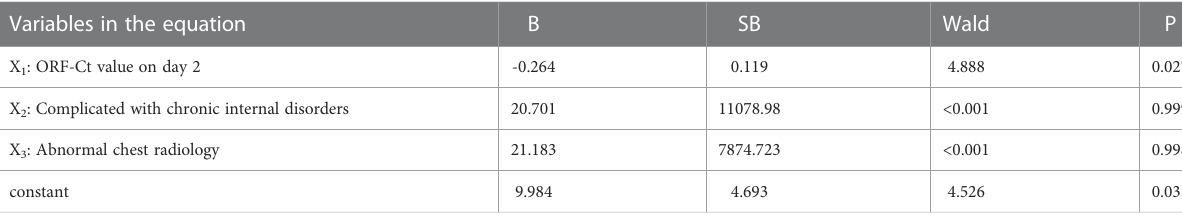
TABLE 5 Regression analysis results of nucleic acid Ct value fl uCtuation. Variables in the